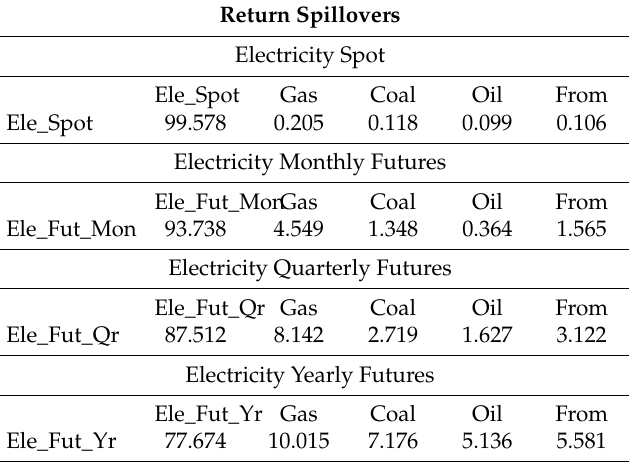
Table 5. The return spillover results of the Diebold–Yilmaz approach (2012). Return